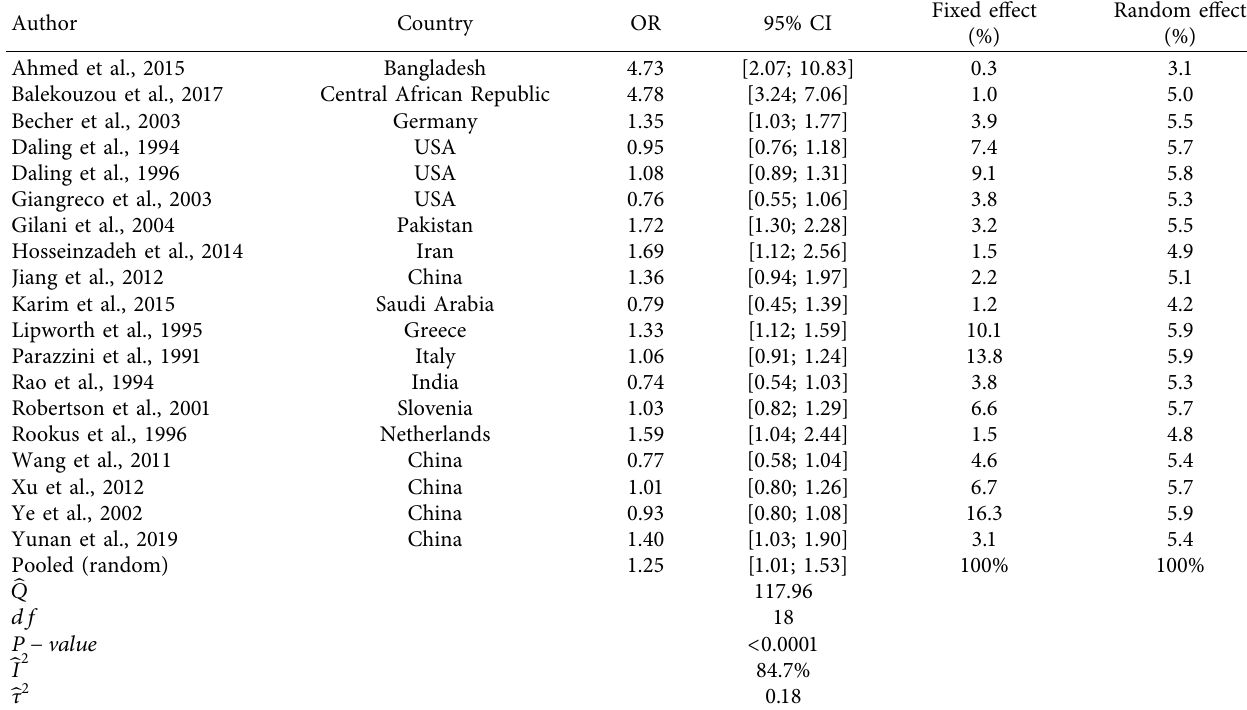
Table 4: Summary of the random efects and fxed efects models for induced